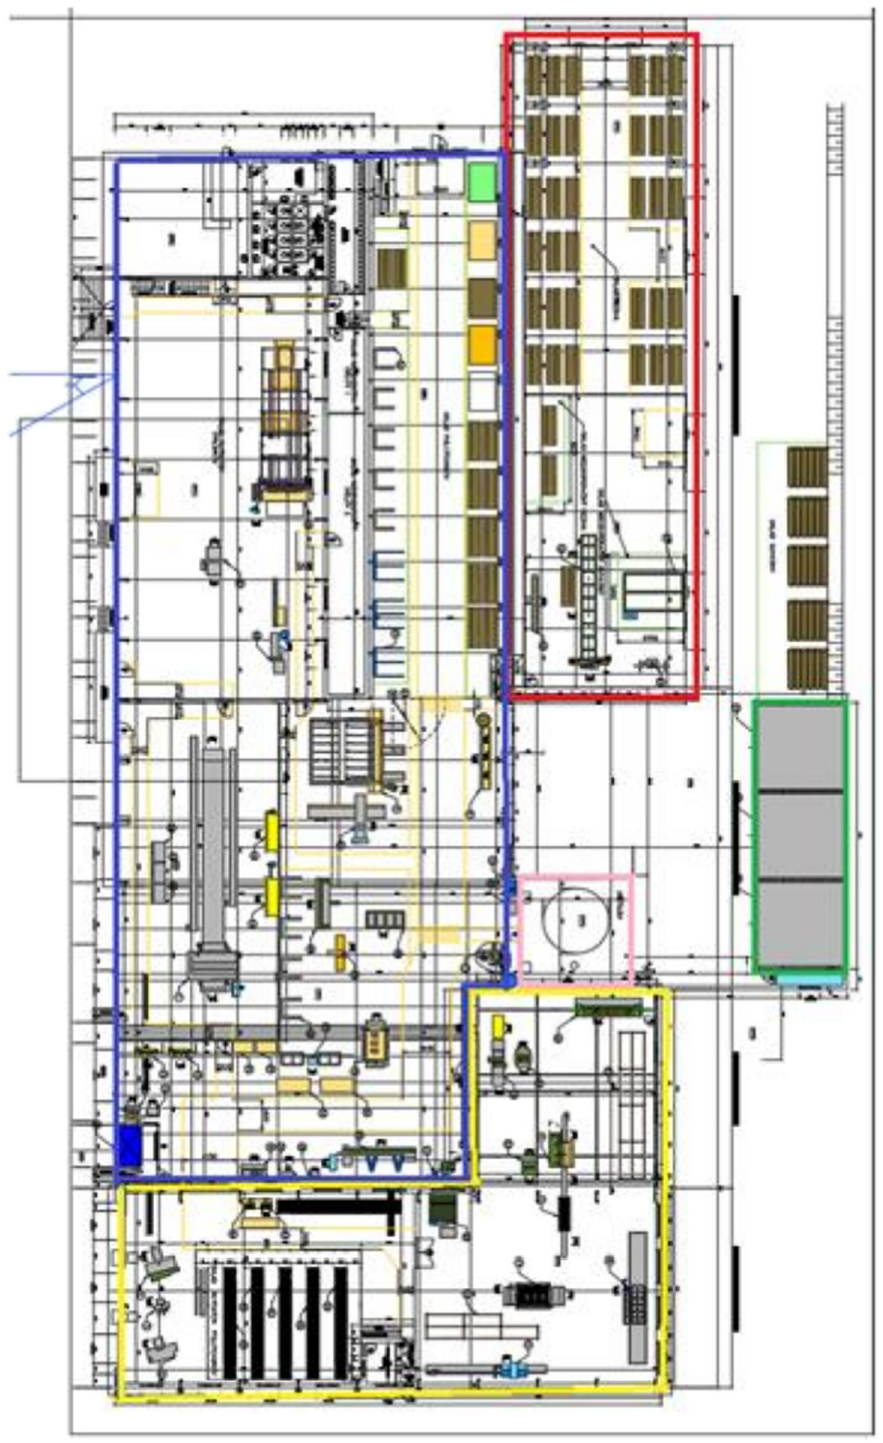
Figure 1: Layout of buildings of the production enterprise ( red line – production hall, blue line – production hall, yellow line – production hall, pink building – drying chamber, green building – administrative building ) . Source: